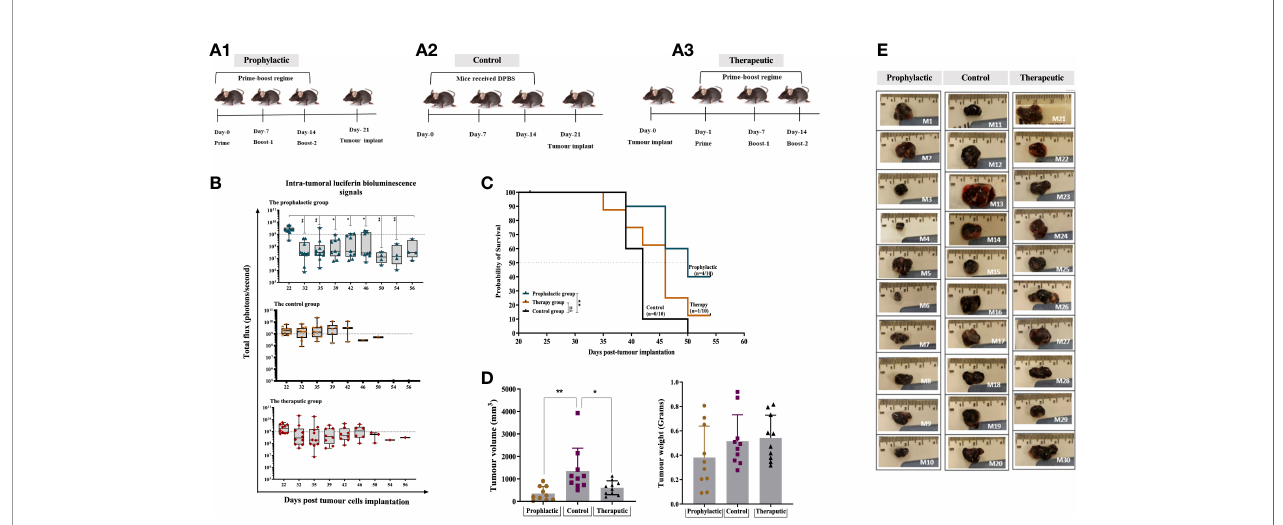
FIGURE 5 | Combined HAGE/WT1 ImmunoBody® vaccines signi fi cantly delay tumour growth in tumour challenge experiment. Schematic representation of the in vivo experimental design is shown in (A) where three groups of mice were used in this study using prime- boost regime. In the prophylactic setting, mice were received the vaccine then challenged with hB16/HAGE + /Luc + cells on Day-21, whereas, in the therapeutic setting, tumour cells were implanted, followed by vaccination in the determined days. The control group of mice received DPBS instead of the vaccine. Intra-tumoural luciferin bioluminescent signals in the vaccinated HHDII/DR1 mice bearing the aggressive hB16/HAGE + /Luc + tumour in comparison to the control are shown in (B) . The fi gure demonstrates the prophylactic and therapeutic ef fi cacy of the combined HAGE/WT1 ImmunoBody ® vaccines, wherein luciferin bioluminescent signals were detected in all groups as a total fl ux measured by photons/second. Data shows that the total fl ux in the prophylactic group and therapeutic declined in comparison with the control, and that both treatment settings led to prolong mice survival rate. Most mice from the control group were culled after Day-39 post transplantation session whereas mice in the vaccinated groups survive while they were holding small size tumour. Post-culled hB16/HAGE + /Luc + tumour weight and volume are shown in (C, D) . For each indicated group, tumour weight in grams and tumour volume in mm3 were determined, and post-culled tumour images highlighted the tumour size shown in (D) . Mice were euthanized when tumour size reached endpoint threshold (12 mm2 for the prophylactic setting and 15 mm2 for the therapeutic setting). (E) Data in these graphs are expressed as the mean ± SD, and the level of the signi fi cance was determined using one-way ANOVA analysis followed by Dunnett ’ s multiple comparisons test. Survival analysis demonstrates the antitumor ef fi cacy of the combined HAGE/WT1 ImmunoBody ® vaccines in vaccinated tumour bearing mice. Results shows that the combined HAGE/WT1 vaccines is signi fi cantly protective in the prophylactic group in comparison to the control group at **P-value<0.01, but not in the therapeutic setting. The signi fi cance of the difference was evaluated by both Gehan-Breslow-Wilcoxon test and log-rank test. The total number of mice is 30, (10/group). *p-value=<0.05, signi fi cant; **p-value=<0.01, very signi fi cant, ns, not signi fi